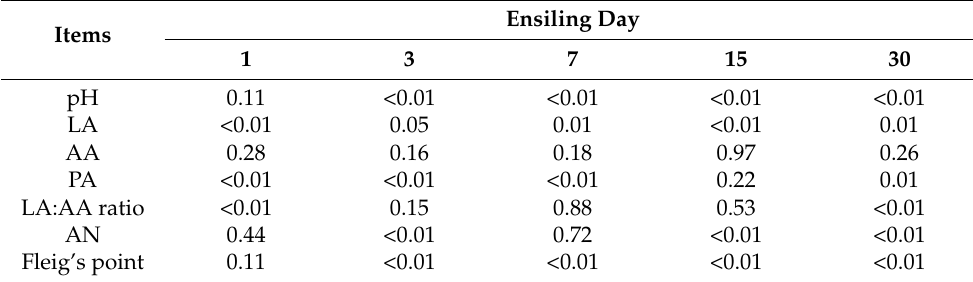
Figure 1. Effect of additives on pH as a function of the number of alfalfa ensiling days. CON, control; PEC, pectin; STA, starch; MOL, molasses; FRU, fructose. A denotes significance of additives; D, denotes significance of ensiling days; A × D denotes the interactive effect between additives and ensiling days. SEM, standard error of means. The asterisks (** p ≤ 0.01) indicate the significance of additives and ensiling days and their interaction effects, and the difference at the specified ensiling day. Table 1. Statistical analysis for the fermentation profile variables of alfalfa silage treated with different carbohydrate sources at different ensiling period.